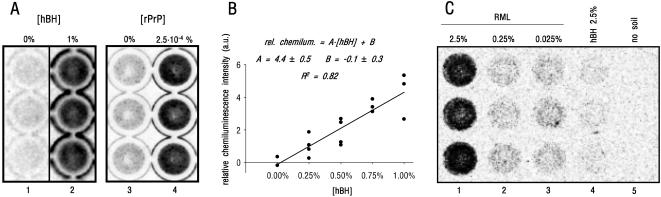
Direct Visualisation of Soil-bound PrPC and PrPSc.(A) Samples (100 mg) of arable sandy loam (ASL) are incubated (1 h, RT; final volume, 200 µl of PBS) in the absence (column 1), or in the presence (1% (w/v), column 2), of healthy mouse brain homogenate (hBH). After sedimentation (30 g, 5 min), collected soil particles are extensively washed, and the presence of soil-bound PrPC immunodetected as described (see Materials and Methods). The same protocol is used for the incubation of ASL in the absence (column 3), or in the presence (column 4), of the indicated concentration (w/v) of recombinant murine PrP (rPrP). Soil-bound immunoreactivity appears as a dark chemiluminescent signal, clearly distinguishable from the background (i.e. observed in the absence of PrP). (B) A titration experiment is reported, in which progressively increasing PrPC quantities are incubated (1 h, RT) with ASL, under conditions of constant total tissue-to-soil ratio. This is achieved by mixing different volume ratios of hBHs (10% (w/v) in PBS) from wild-type (WT) and PrP-knockout (KO) mice (WT∶KO (µl∶µl) 0∶20, 5∶15, 10∶10, 15∶5, 20∶0) (final volume, 200 µl of PBS). The resulting final concentrations (w/v) of WT brain homogenates (hBH) are as indicated. The relative amounts of immunodetected soil-bound PrPCs, determined by the densitometric analysis of the collected chemiluminescence, subtracted for the background signal ([hBH] = 0%), are reported (in arbitrary units, a.u.) in the scatter plot as a function of [hBH]. Regression analysis indicates a linear relation (with a p value<0.05 (t-Student test)), at least within the tested concentration range, and demonstrates that the assay is specific for PrPC. Reported are also the regression line, the regression equation (with the standard error for the slope and the intercept) and the R2 value. Other experimental details are as in (A). (C) To visualise soil-bound prions (columns 1–3), ASL samples are incubated with the indicated final concentrations ((w/v) in PBS) of RML-infected mouse brain homogenates (serially diluted into non-infected (2.5%) homogenates), before applying to purified soil pellets the above described immuno-based procedure, implemented with PK digestion and addition of guanidinium thiocyanate (see Materials and Methods). The obtained dark immunosignal, readily appreciable with respect to soil samples incubated with hBH (2.5%, column 4), is therefore indicative for the presence of PK-resistant soil-bound PrPSc. The null response, obtained by processing RML-brain homogenates (2.5%) in the absence of soil (no soil, column 5), demonstrates that the signal is specific for PrPSc adsorbed onto soil surfaces, rather than resulting from (contaminating) not bound PrPSc. Other experimental details are as in (B).